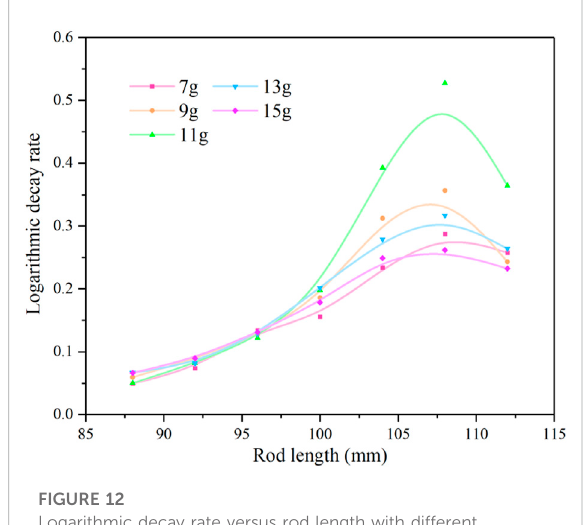
FIGURE 12 Logarithmic decay rate versus rod length with different magnetic fl uid